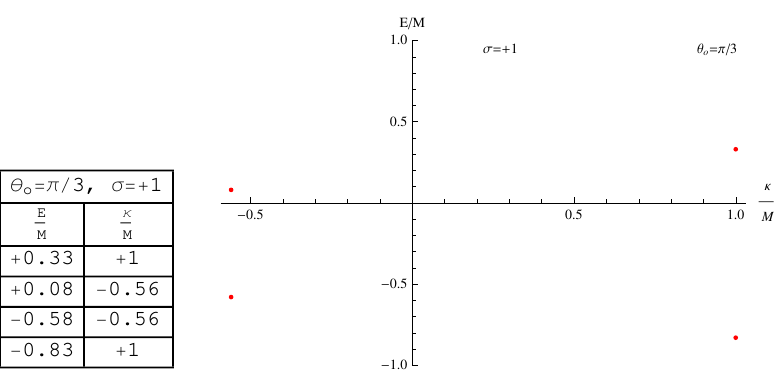
Figure 4 . The left table shows the E/M and κ/M values for θ 0 = π/ 3 , σ = 1 .The right figure shows the points with coordinates ( κ/M , E/M ) .